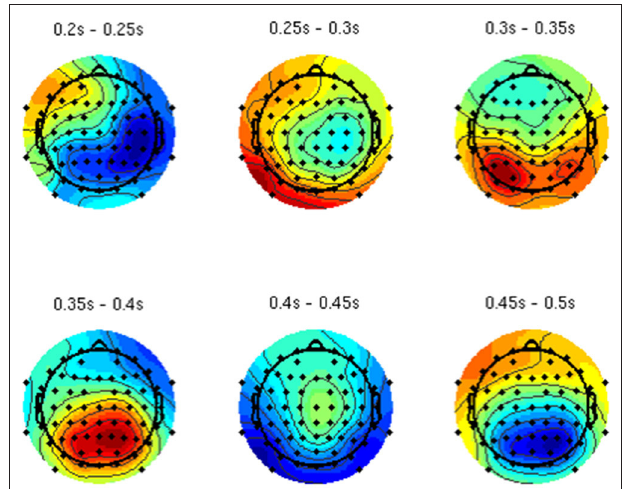
FIGURE 5 | The pattern of ERPs (face vs. no